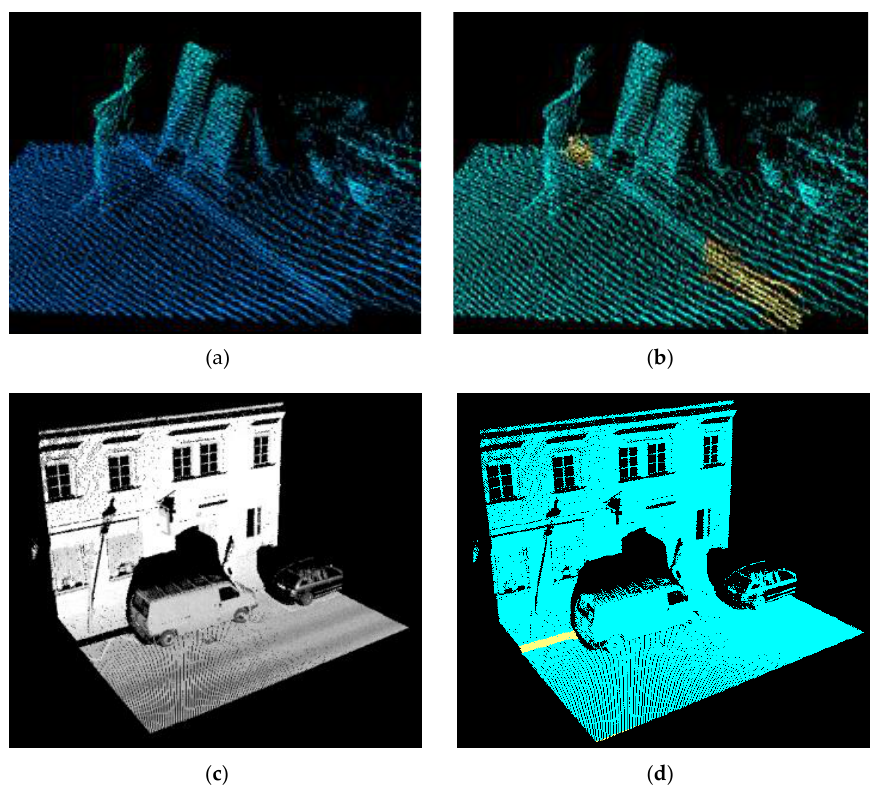
Figure 11. Two cases of false negatives at Test Site 1 and 2. The curb is not detected due to an element over it ( a,b ). The short curb between cars is removed in the morphological operation procedure ( c,d ).